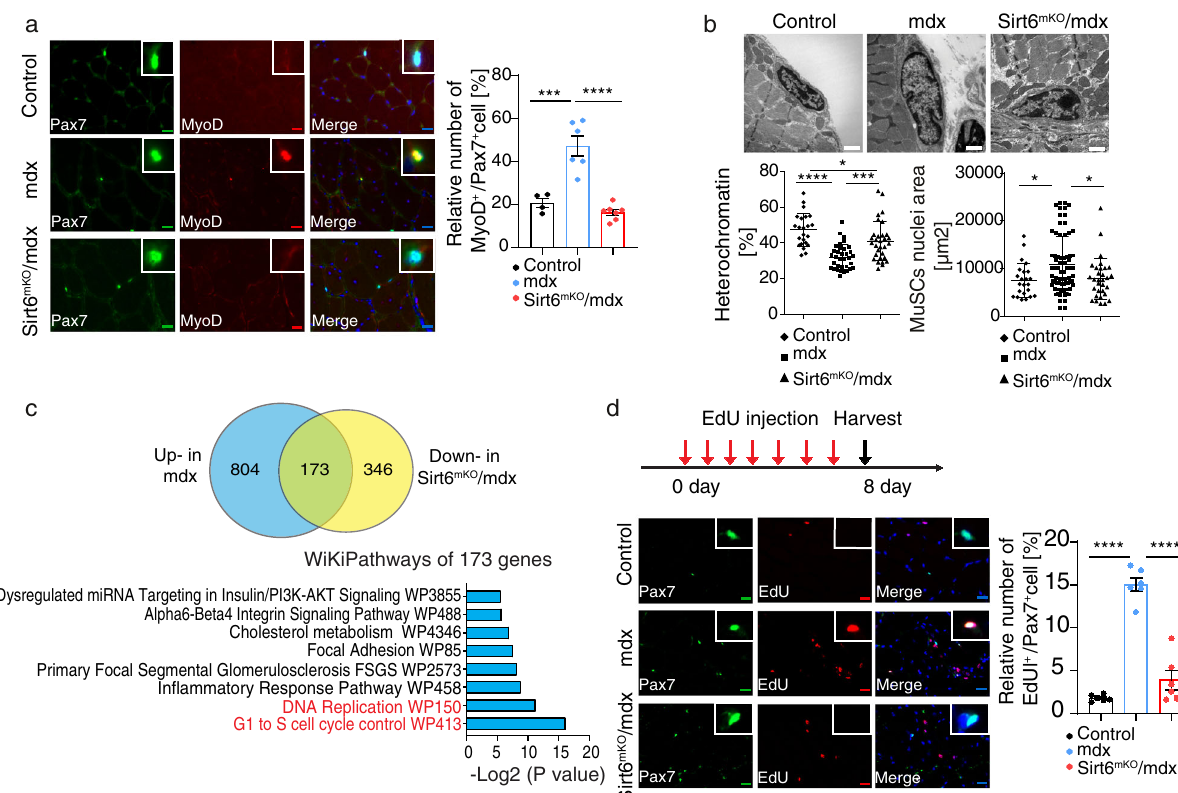
Fig. 2 Deletion of Sirt6 reduces persistent activation of MuSC in skeletal muscles of mdx mice. a Immuno fl uorescence staining of MYOD + /PAX7 + double positive MuSCs in TA muscles of control ( n = 4), mdx ( n = 6) and Sirt6 mKO /mdx ( n = 7) mice. Scale bar: 20 µ m. The ratios of MYOD + /PAX7 double positive MuSCs are shown in the right panel (one-way ANOVA with Bonferroni multiple comparisons test: *** p = 0.002, **** p < 0.0001). b EM images of increased heterochromatin content and decreased nuclei size in MuSCs of Sirt6 mKO /mdx mice. Scale bar: 2 μ m. Recordings were quanti fi ed with ImageJ software and are shown in the lower panels (one-way ANOVA with Bonferroni multiple comparisons test: heterochromatin content **** p < 0.0001, *** p = 0.0004; * p = 0.0379; nuclei size: * p = 0.0374, * p = 0.0361, control: n = 23; mdx : n = 35; Sirt6 mKO /mdx : n = 31). c Venn diagram of upregulated genes in mdx MuSCs compared with control MuSCs and downregulated genes in Sirt6 mKO /mdx MuSCs compared to mdx MuSCs (upper panel) based on RNA-seq analysis. GO term analysis of WikiPathways enriched in overlapping set of 173 genes based on p values (lower panel) using Enrichr. d Immuno fl uorescence staining of EdU + /PAX7 + MuSCs in TA muscles of control, mdx and Sirt6 mKO / mdx mice. Scale bar: 20 μ m. A schematic outline of the experimental design is shown in the upper panel. Quanti fi cation of EdU + /PAX7 + MuSCs is shown on the right (one-way ANOVA with Bonferroni multiple comparisons test: **** p < 0.0001, n = 6). Twelve to 16 weeks old male mice were used. Data are presented as mean ± SEM ( a , b , d ). Source data are provided in the Source Data fi